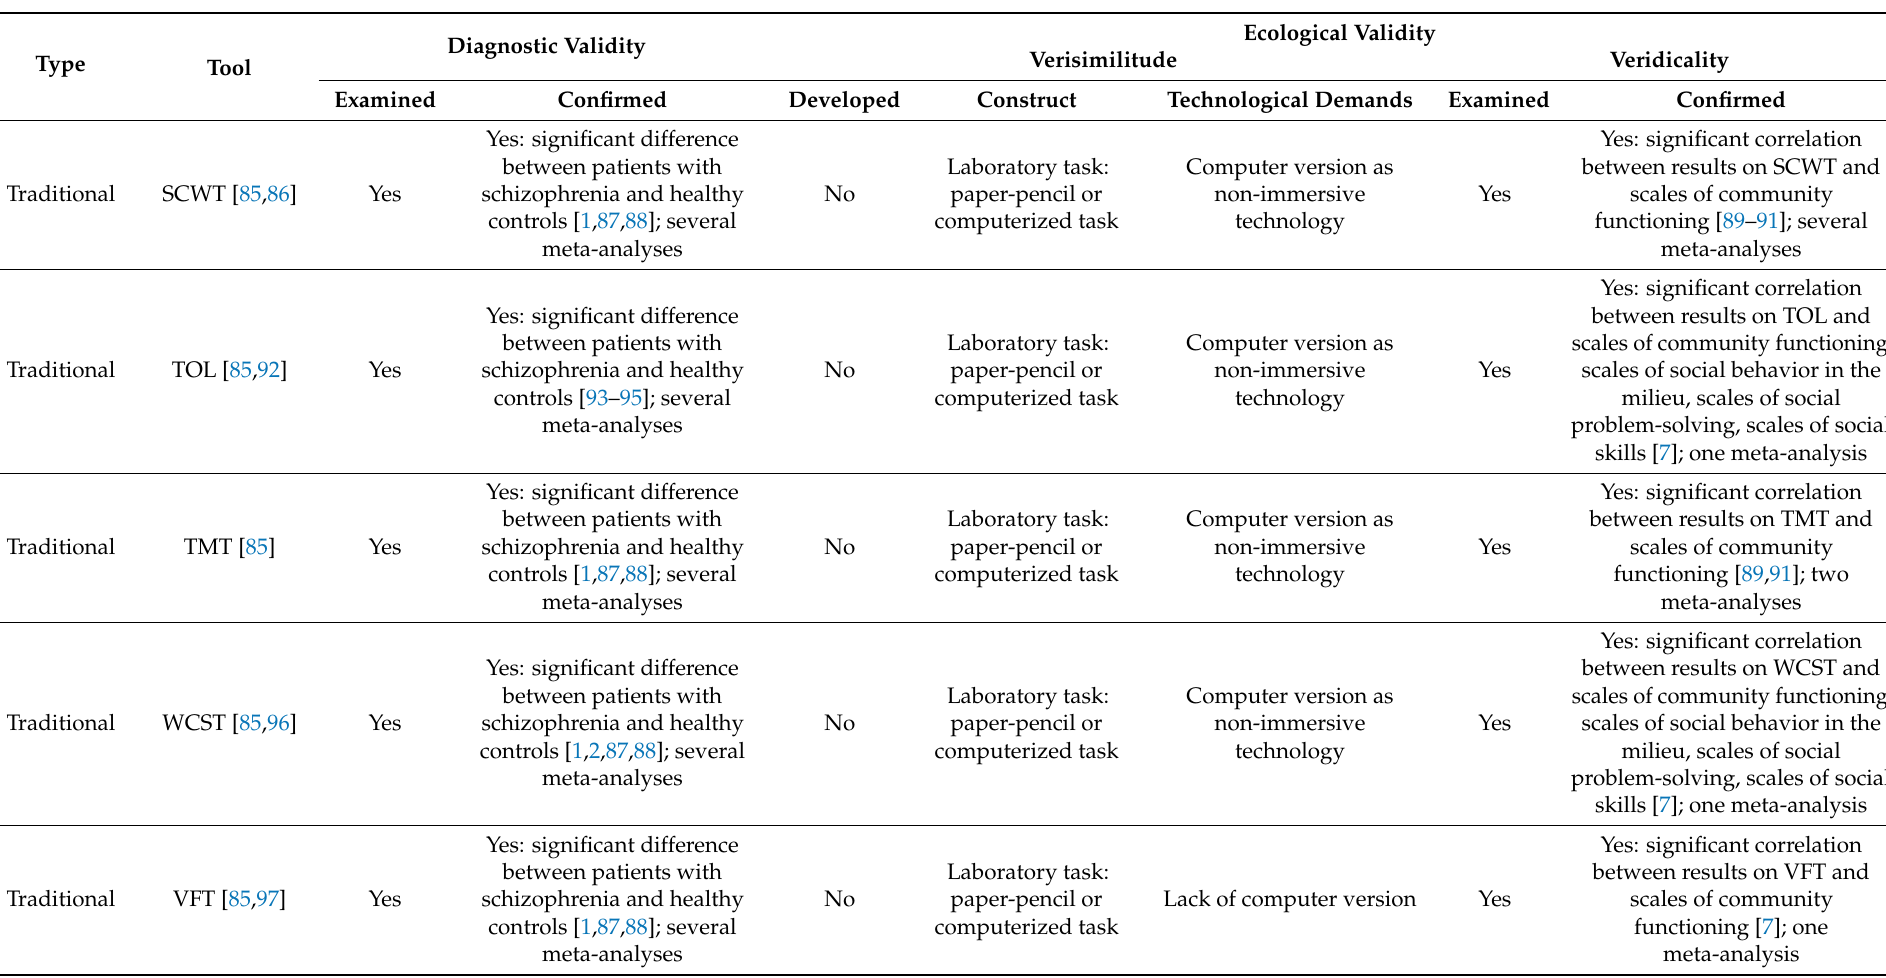
Table 1. Characteristics of and evidence for diagnostic validity and two dimensions of ecological validity (verisimilitude and veridicality) of traditional, ecological, and VR tools that measure executive functions in